Question: Does the figure show an increasing or a decreasing trend?
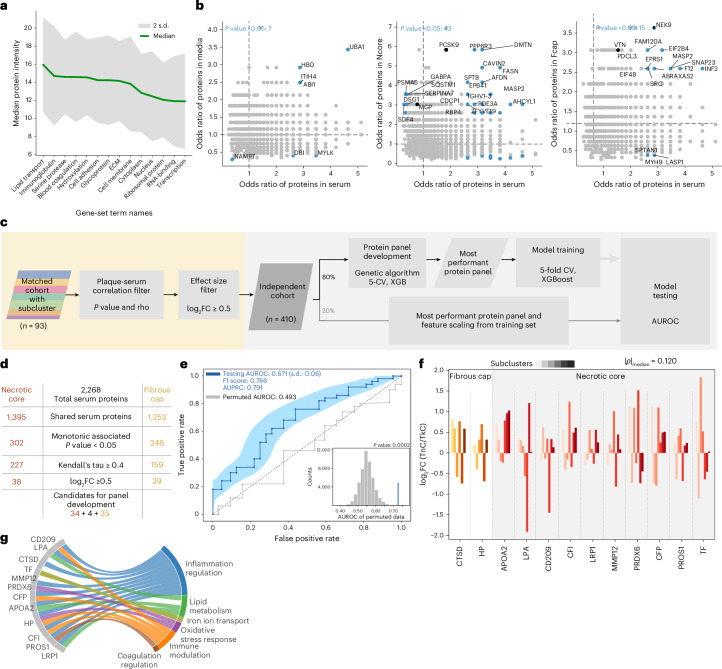
Answer: increasing